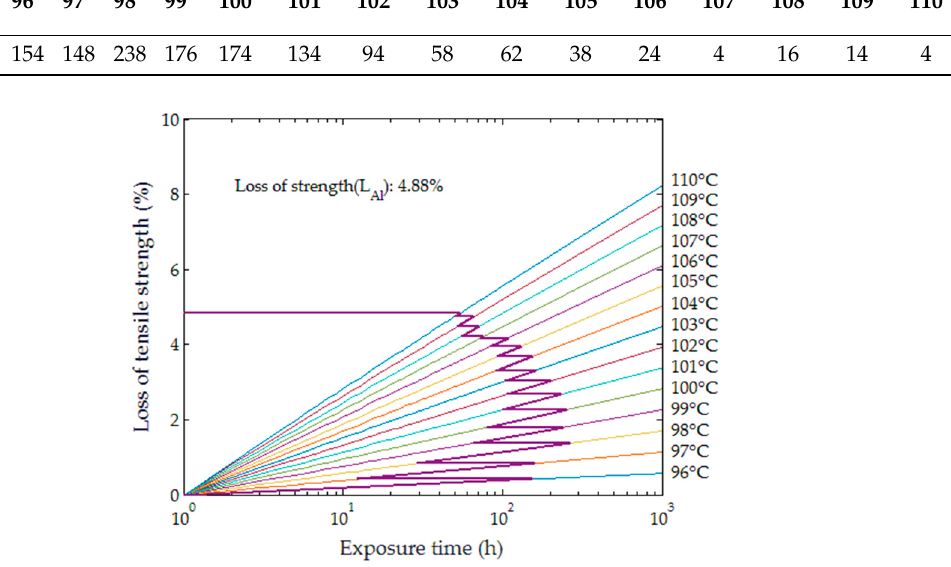
Figure 10. Determination of the loss of tensile strength of an individual aluminum strand (98% confidence level).